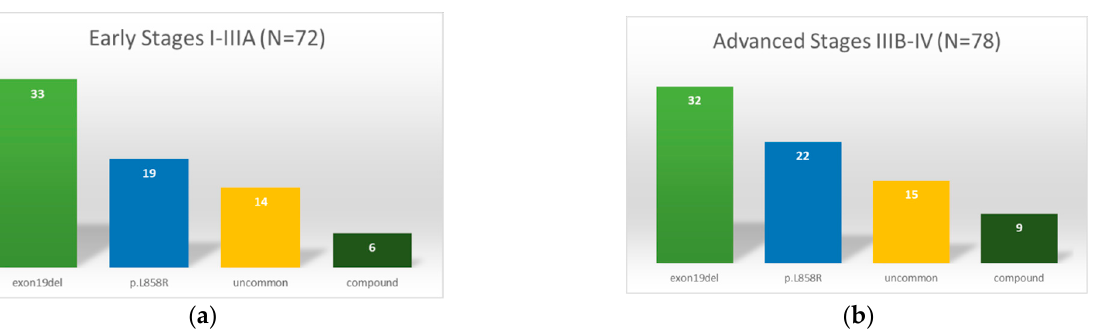
Figure 2. Classification and distribution of EGFR mutations in pulmonary adenocarcinoma: ( a ) adenocarcinoma in early-stage NSCLC (stages I–IIIA), ( b ) adenocarcinoma in advanced NSCLC (stages IIIB–IV).